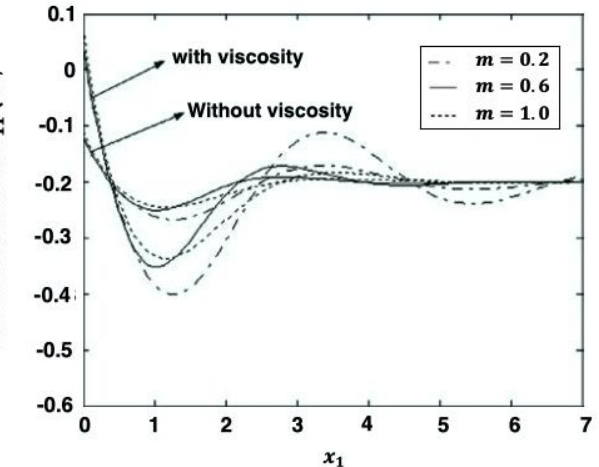
Figure 5. Biothermal stress 𝝈 𝟏𝟏 wave fluctuations along 𝒙 𝟏 – axis for different functionally graded parameter values.